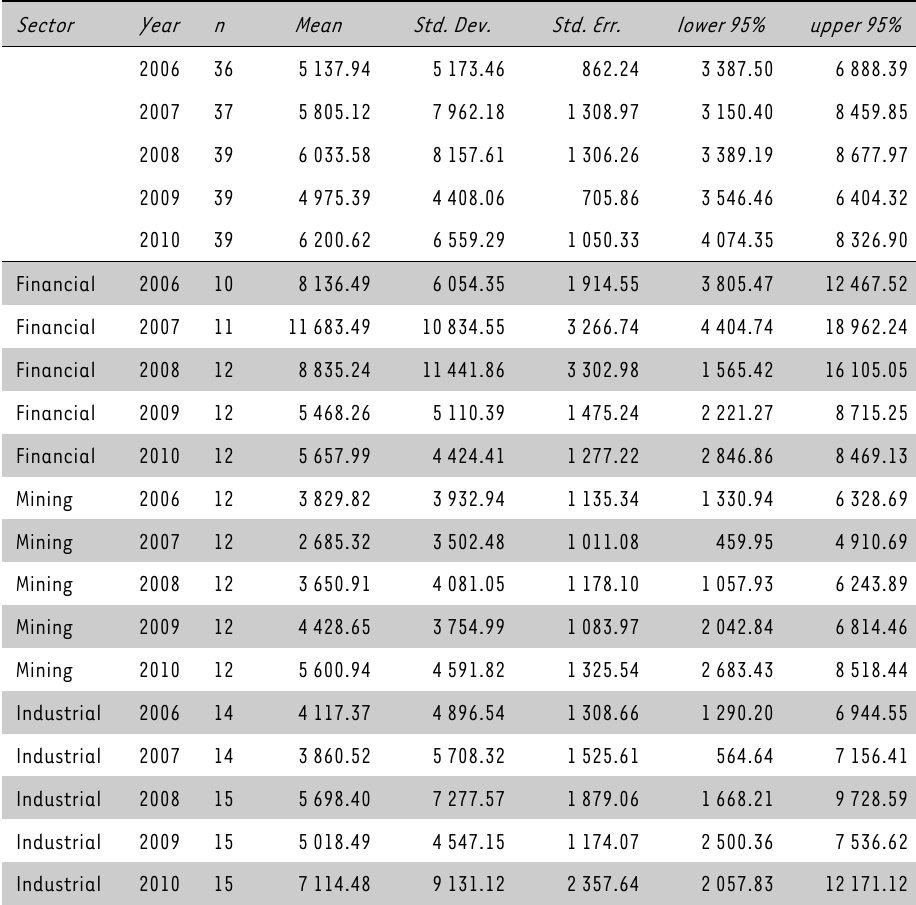
TABLE 3: Descriptive statistics for bonus All figures except for n are given in thousands, and refer to South African